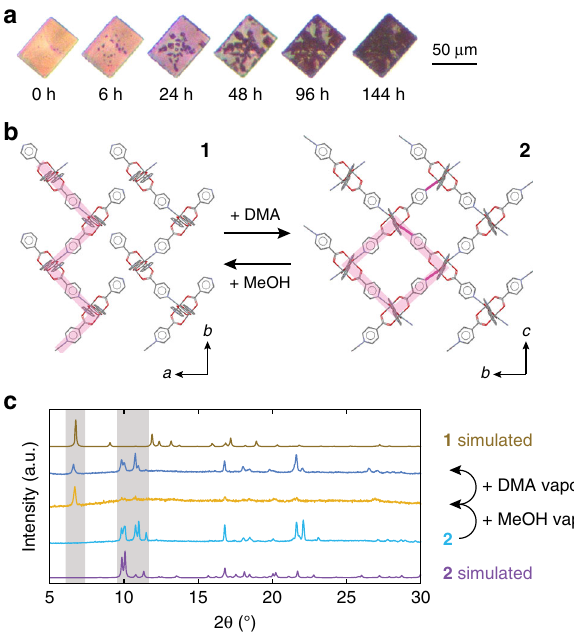
Fig. 3 Reversible structural switching between 1 and 2. a Photographs of a single crystal of 1 exposed over time to dimethylacetamide (DMA) vapor. b Single-crystal structures of 1 (left) and of 2 (right) showing how exposure to DMA and methanol can facilitate interconversion between the two structures. Solvent molecules have been omitted for clarity. c Simulated and experimental powder XRD scans of bulk samples of 1 and 2 used to demonstrate reversible conversion between the MOF